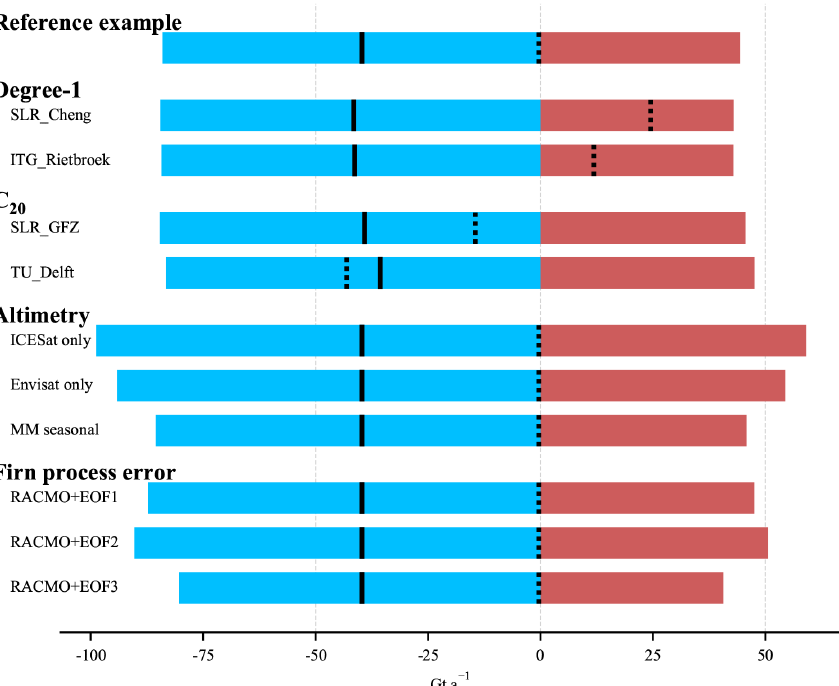
Figure 6. Mass change results for the entire AIS over the interval March 2003–October 2009 from experiments with different data products and methodological choices. The LPZ-based bias correction was applied. Debiased total-mass change (solid black lines) is separated into debiased GIA-related mass (red) and ice mass change (blue). Dotted lines show the total-mass changes that arise when no bias corrections are applied. The case of no bias correction is further illustrated in Fig. S7.